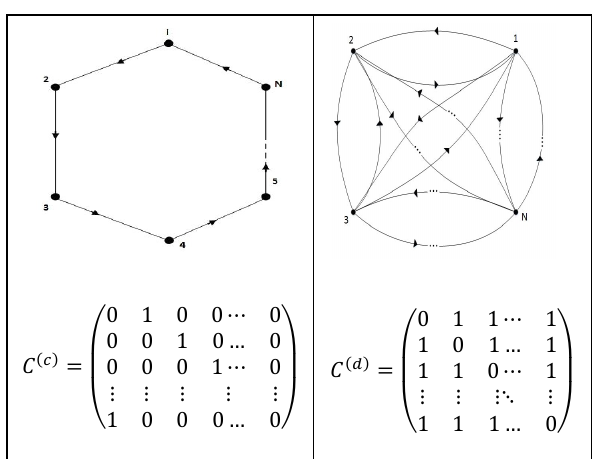
Figure 5 . The cyclic and decentralized structure [1]